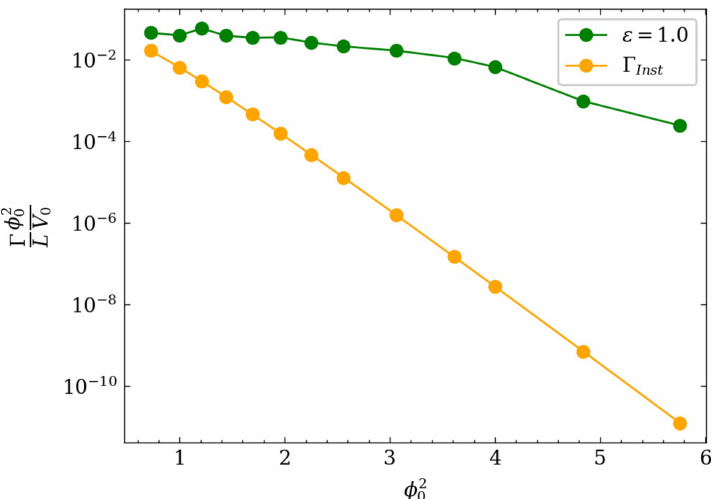
Figure 9 . Tunneling rate in 1+1 dimension for larger values of φ 0 . Simulations parameters are N x = 512 , am f = 0 . 06 .